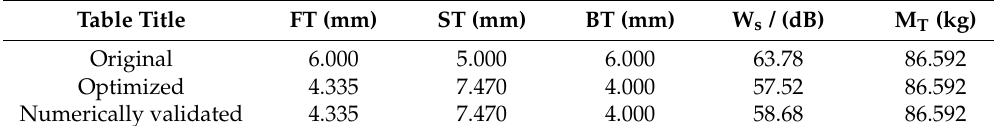
Table 5. The optimization results with the volute total mass invariable.